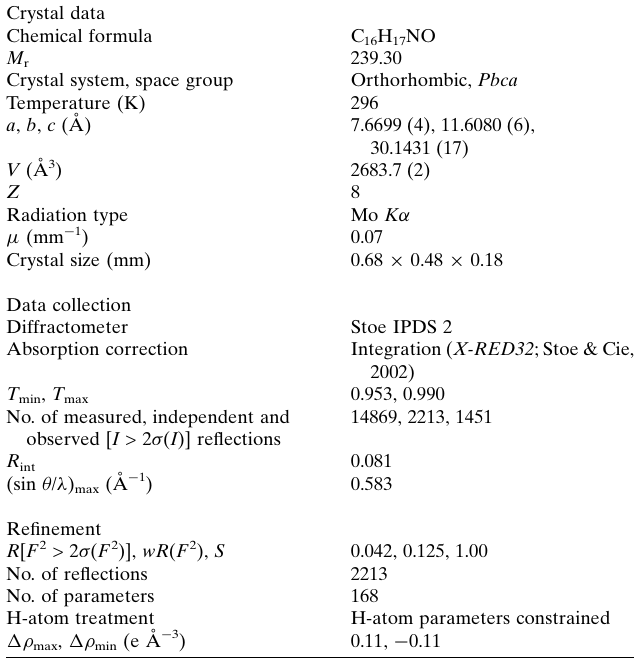
Table 2 Experimental